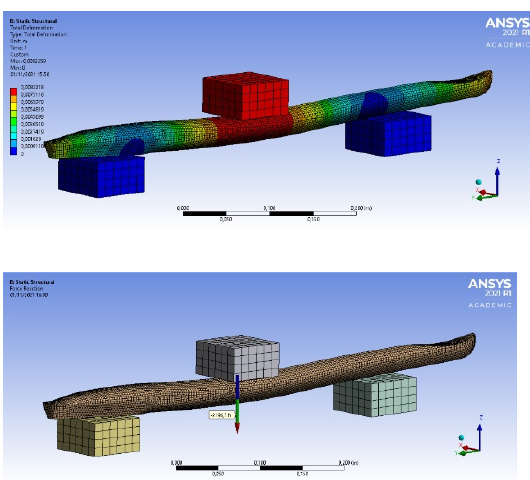
Figure 15. Filava quadriaxial (displacement 9.40 mm, resulting force 3875 N).